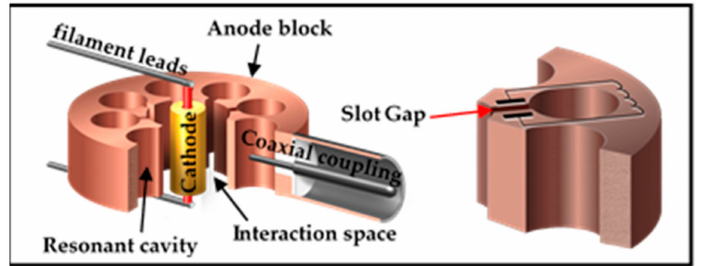
Figure 1. The structures and resonant cavity of the